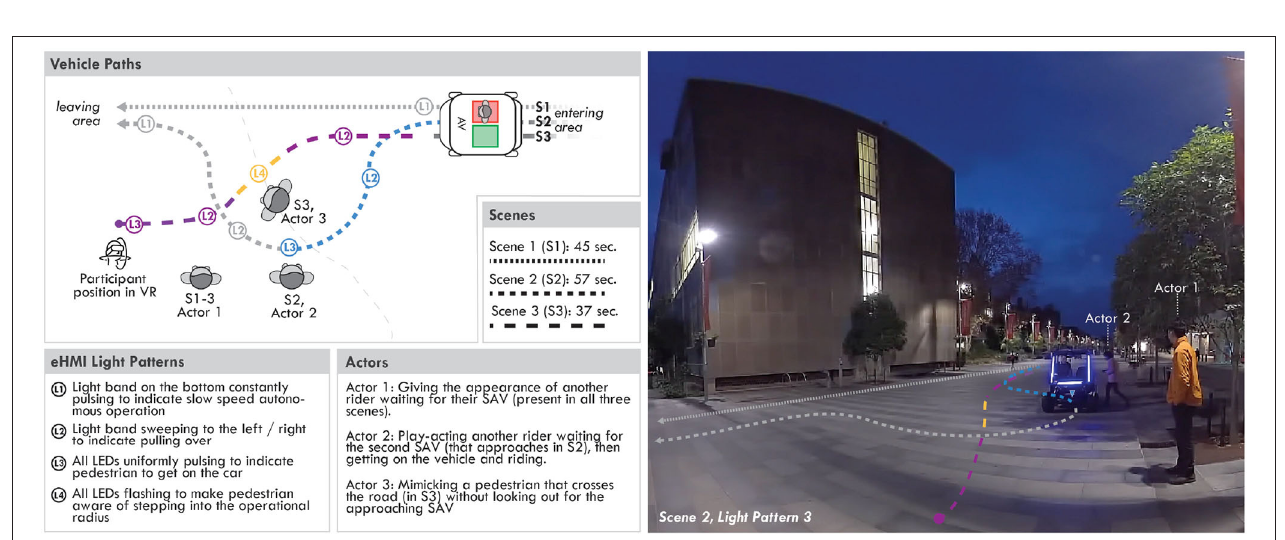
FIGURE 3 | Overview of the encoded eHMI messages and light patterns linked to the previously identified situations. Light pattern L1-L3 are in purple color which we used in the VR study for participants to indicate their vehicle.